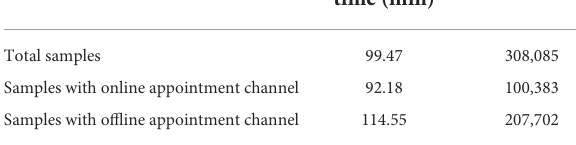
TABLE 2 The descriptive statistics of waiting time for different groups.